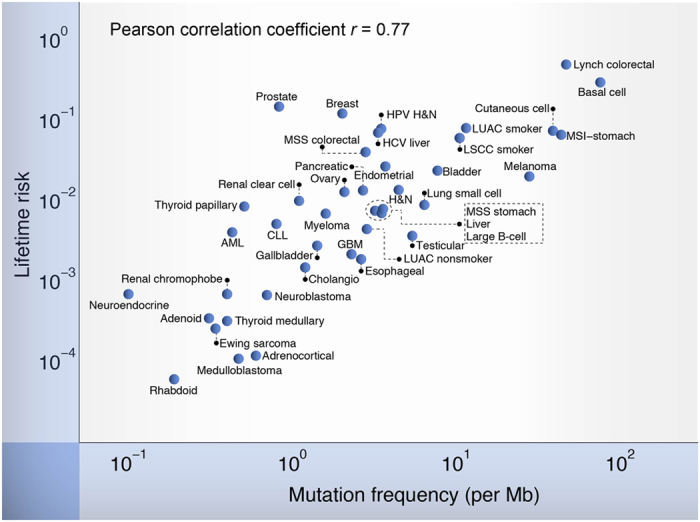
The correlation between the lifetime risk of cancer and the mutation frequency in tissue bulk of that cancer.Values and cancer names corresponding to the abbreviations in the figure are shown in Supp. Table S1.